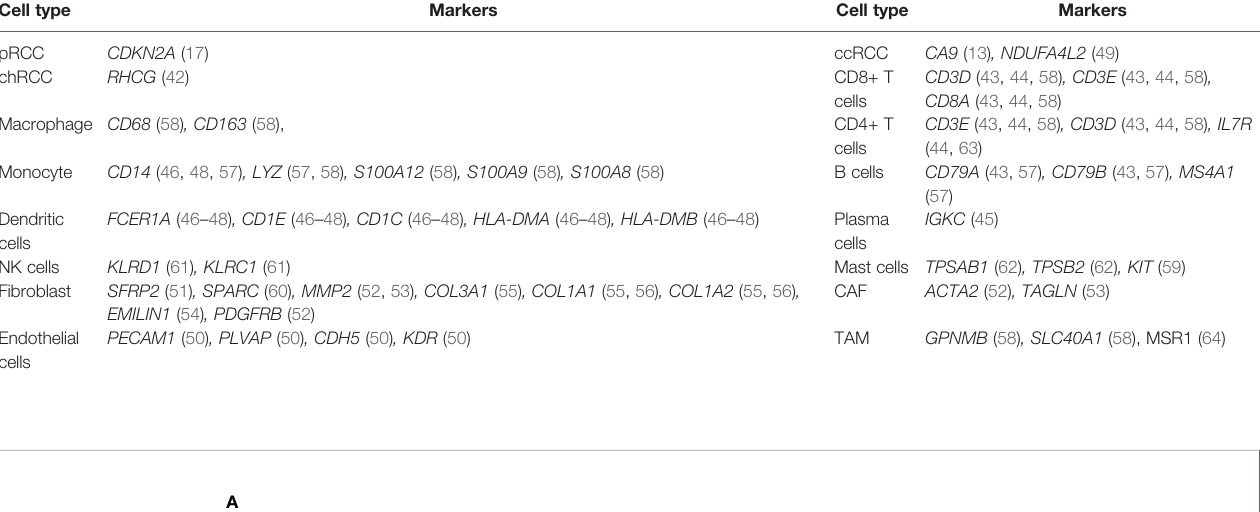
TABLE 1 | Cell-type assignment based on the marker genes reported in previous